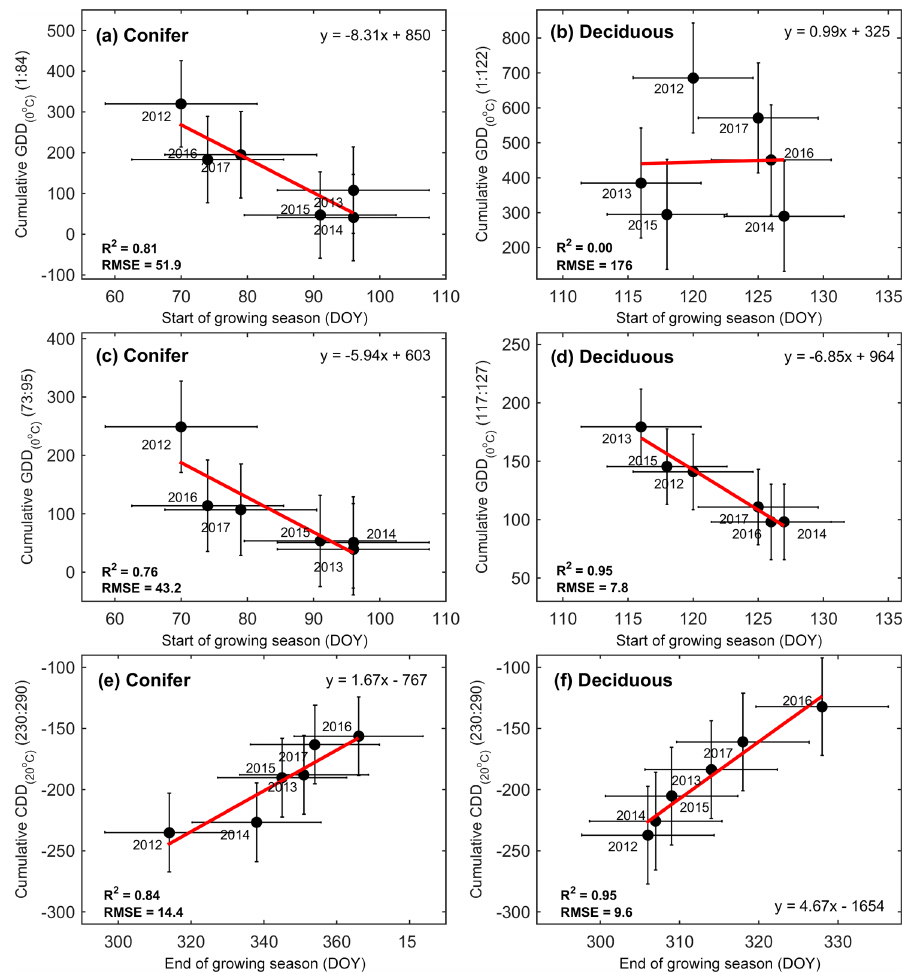
Figure 4. Correlations between growing degree days (GDDs), cooling degree days (CDD), the phenological start of the growing season (SOS), and the end of the growing season (EOS) from 2012 to 2017 at both the conifer and deciduous forests. Shown are (a) cumulative GDDs from 1 January to the mean SOS at TP39 and (b) TPD, (c) cumulative GDDs from the mean SOS ± standard deviation at TP39 and (d) TPD, and (e) cumulative CDDs from DOY 230 through 290 at TP39 and (f) TPD. Error bars represent the standard deviation of the data, with R 2 , RMSE, and linear fit equations included for each